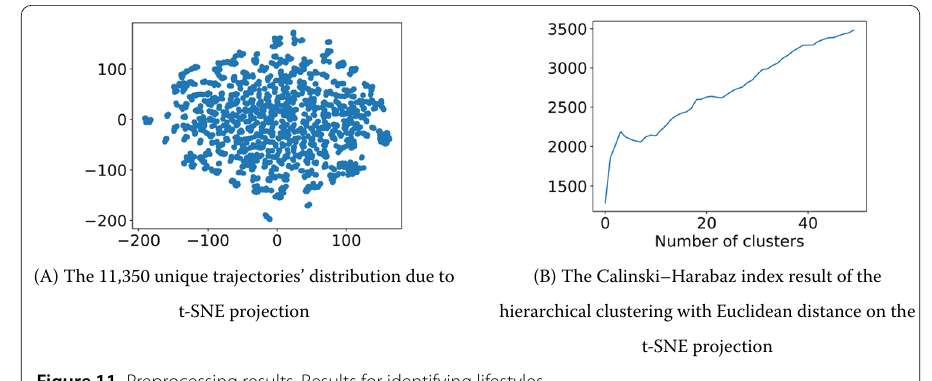
Figure 11 Preprocessing results. Results for identifying lifestyles